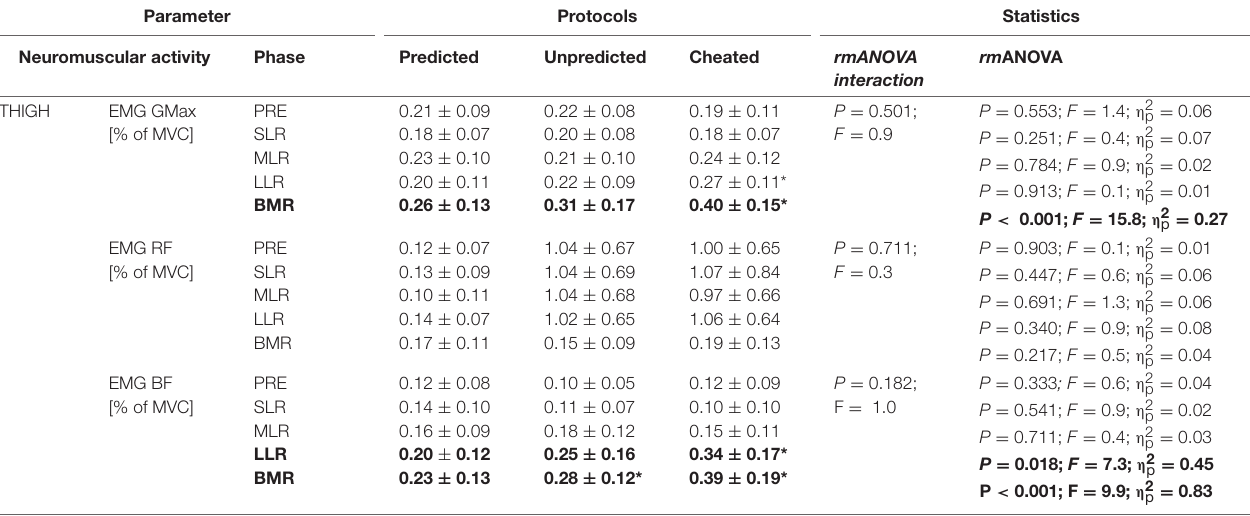
TABLE 3 | Neuromuscular parameters; grand means of EMG integrals during pre-activation (PRE, − 100 to 0ms), the reflex phases SLR, MLR, LLR, and the BMR (120 ms–individual peak of COP) after perturbation, for the muscle groups encompassing the hip (gluteus maximus, GMax) and knee (RF, rectus femoris; BF, biceps femoris) are